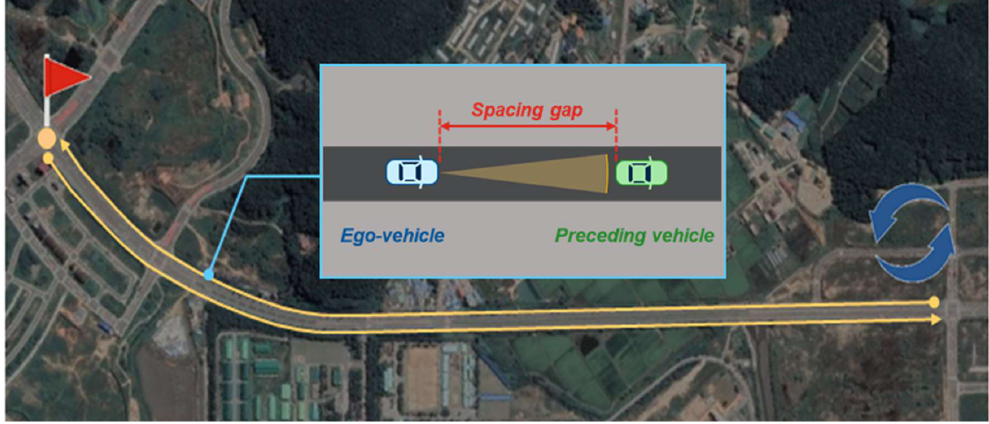
Figure 2. Driving data acquisition site.